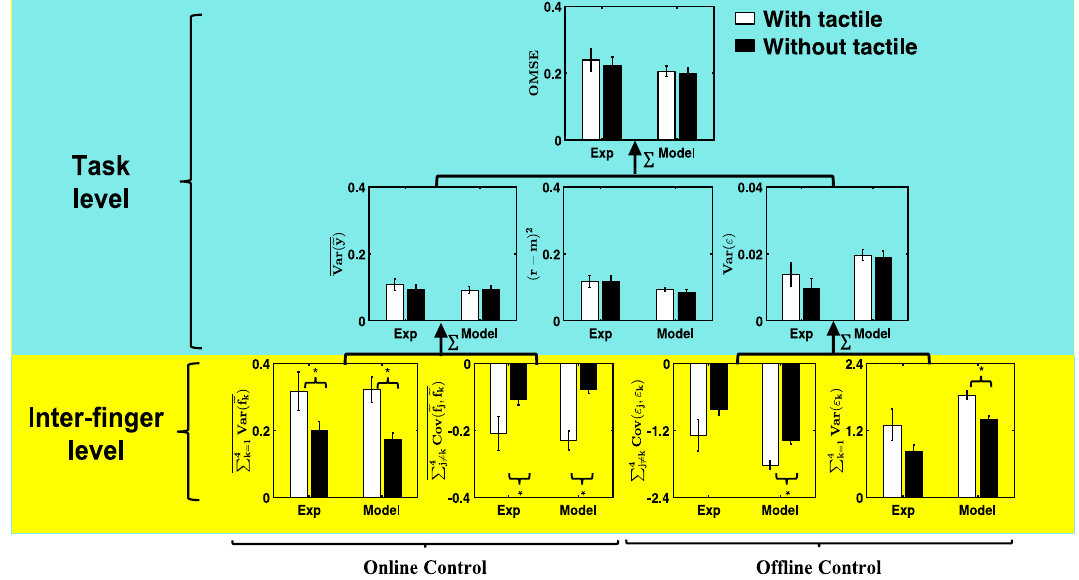
Figure 5. The HVD analysis for the experiment and simulation. The white and black bars show with and without tactile feedback conditions. At task level, the OMSE is equal to the sum of online variance ( Var ( ˜ y ) , offline variance ( Var (ε) ) and systematic error (( r-m ) 2 ). At inter-finger level, shown in yellow, the online and offline variances can be further partitioned into the sum of individual finger force variances (i.e., 4 Var (ε k ) for offline), plus the sum of between finger force covariances (i.e., online, and k = 1 4 (cid:31) Cov (ε j , ε k ) for offline). The negation of covariance is mathematically equal to the index of online, and j = k (cid:31) synergy. Both model and experiment demonstrate significant differences between the two tactile conditions in 4 4 Cov ( ˜ f j , ˜ f k ) . The model shows differences between two conditions in Var ( ˜ f k ) and j = k k = 1 (cid:31) (cid:31) error bars for experiment and model represent the standard error across participants and runs of simulations (216 times = number of subject*number of trials),